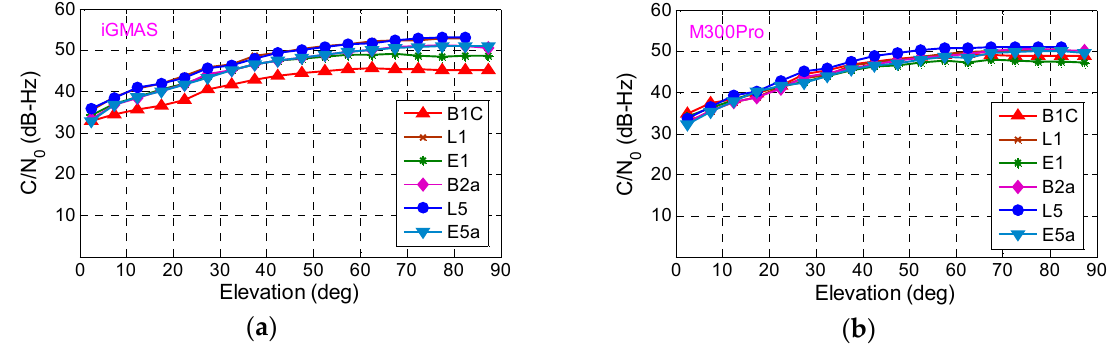
Figure 3. Average C / N 0 values against elevation for each available signal for the iGMAS ( a ) and Figure 3. Average C/N 0 values against elevation for each available signal for the iGMAS ( a ) and M300Pro ( b ) M300Pro ( b ) receiver.